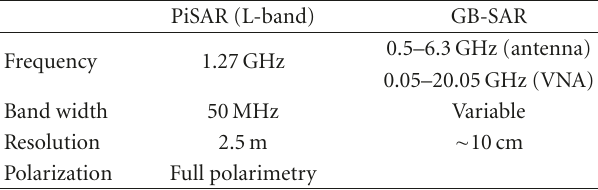
Table 1: Characteristics of PiSAR and GB-SAR.